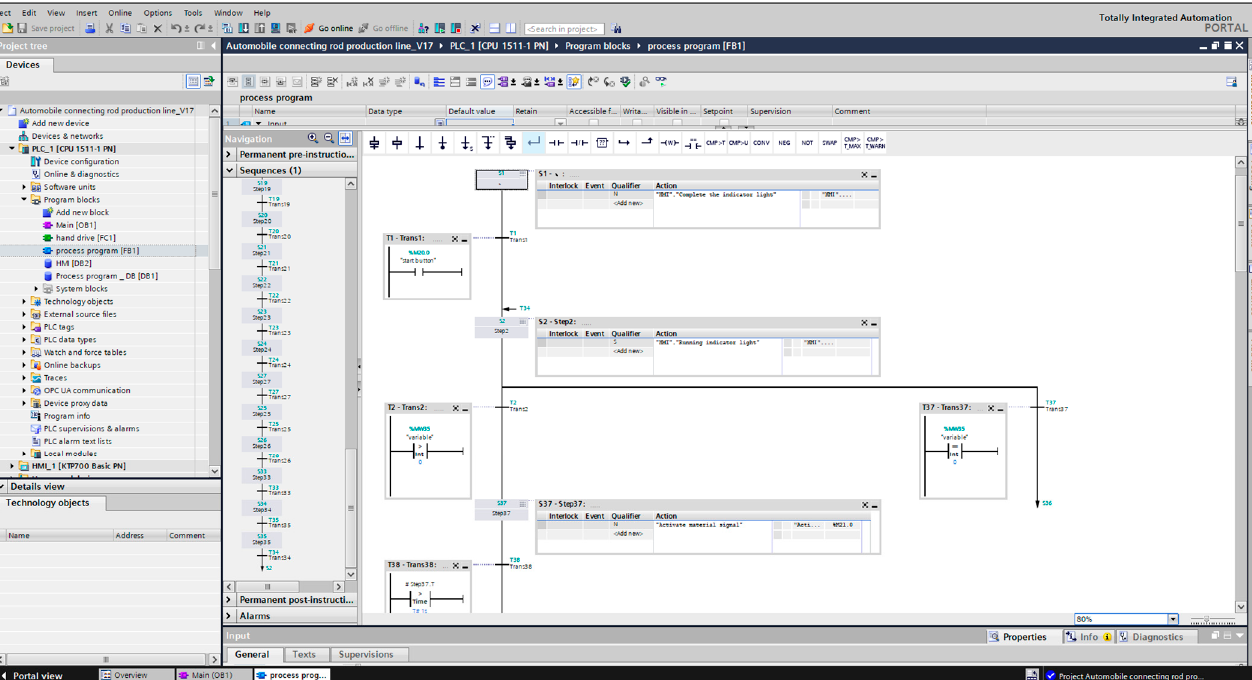
Figure 12. Sequence control system program.